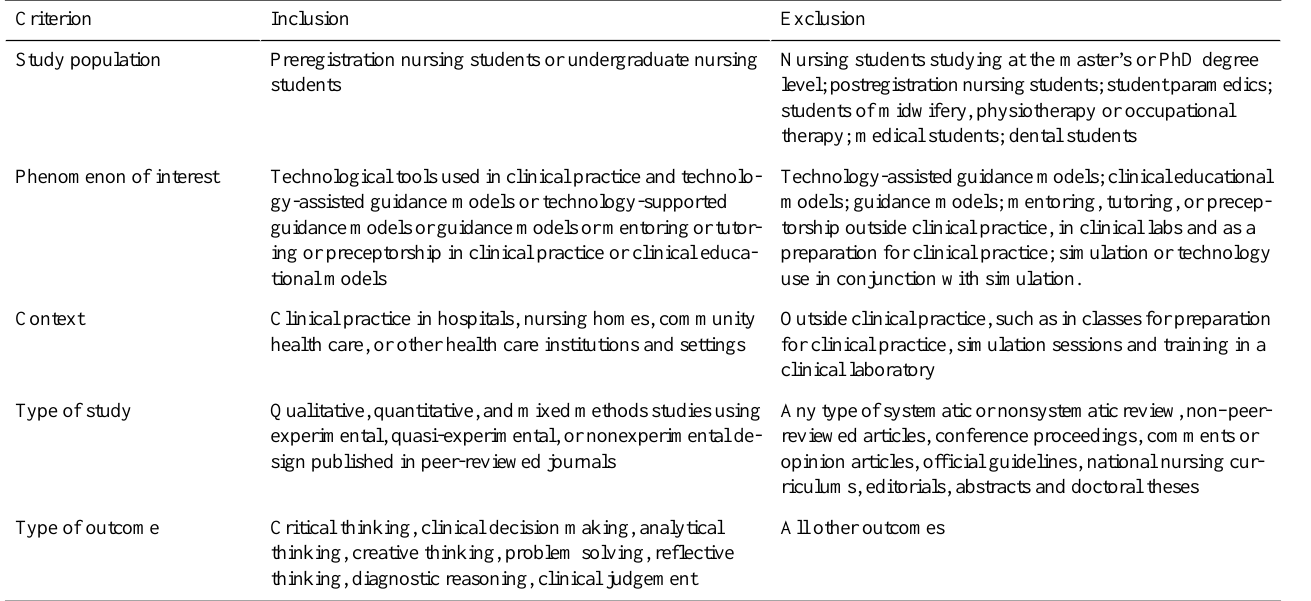
Table 1. Inclusion and exclusion